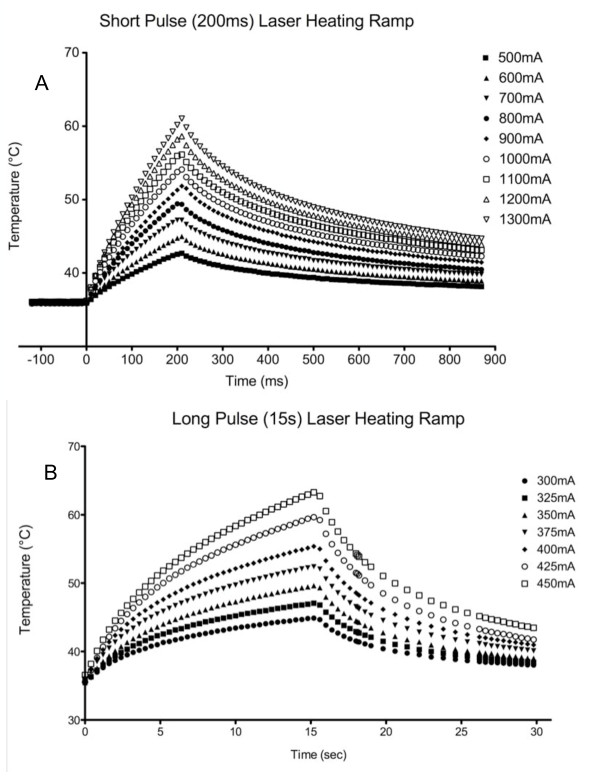
Skin Temperature Changes in Response to Laser Diode Stimulation. Surface skin temperature was measured using a high-speed thermal camera, and showed a decelerating increase in temperature produced by the constant intensity stimulus. This observation was true both for short, high power and long, lower power laser diode stimuli.